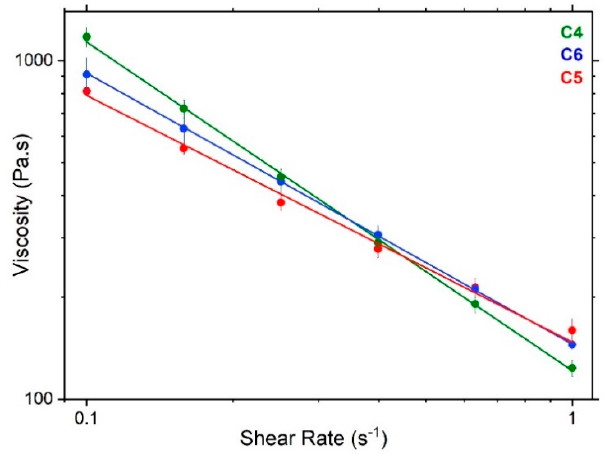
Figure 2. Power-law fitted log-log viscosity flow curves for the 10% creams one day post preparation,